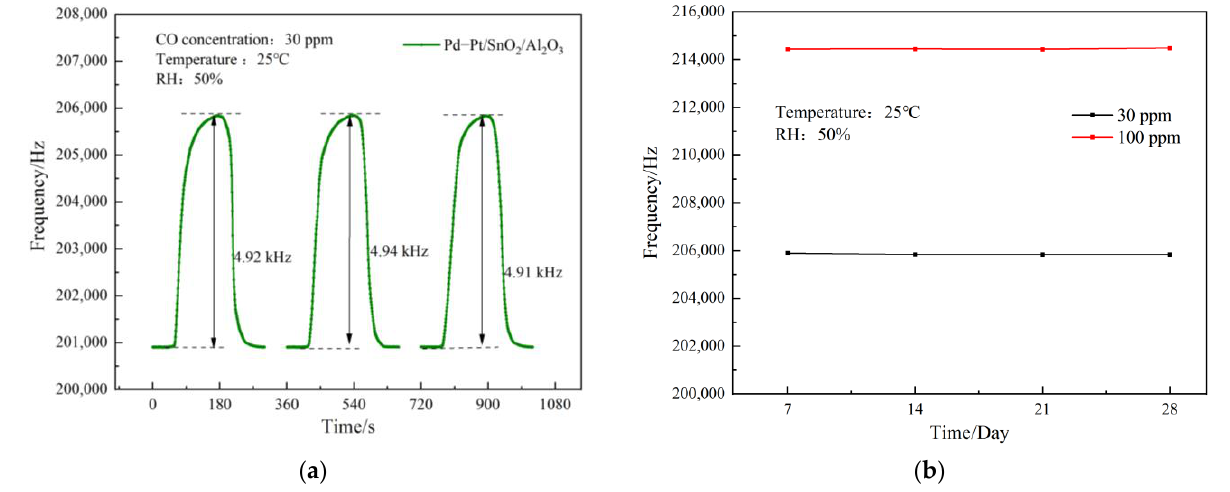
Figure 9. SAW sensor stability testing: ( a ) short-term stability; and ( b ) long-term stability.